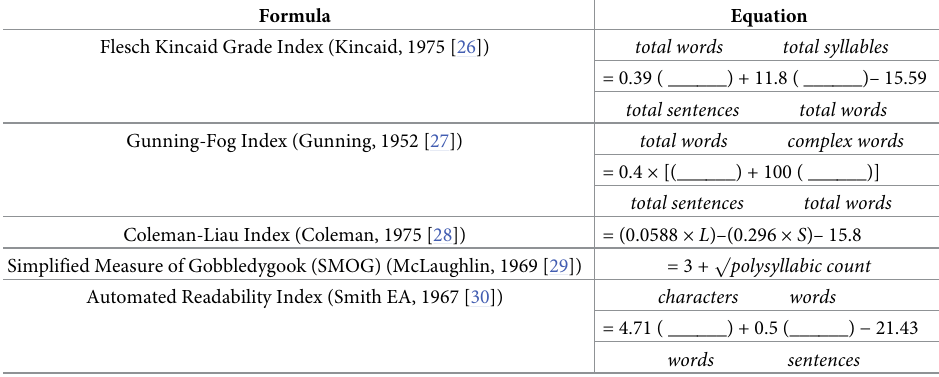
Table 2. Readability formulae used in the study with their